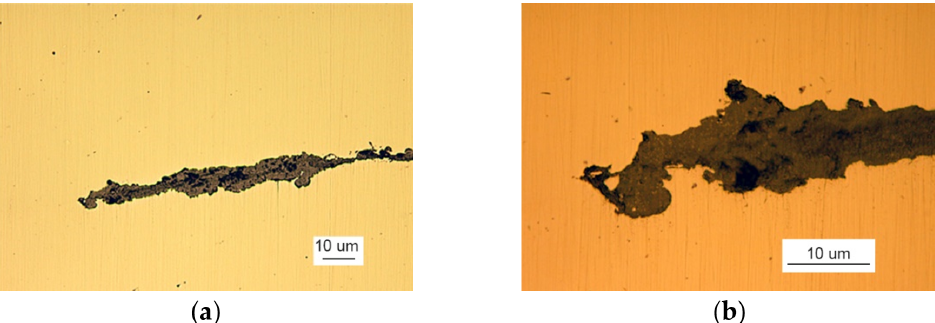
Figure 7. A crack view: ( a ) a crack filled with corrosion products and ( b ) branching crack face (handy-size bulk carrier 30182 DWT). Optical microscopy.